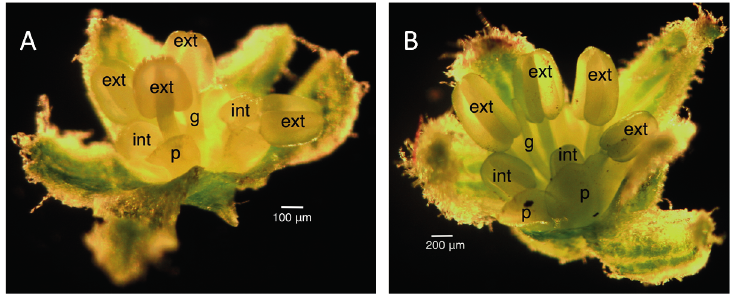
Figure 4. Stages 8 ( A ) and 9 ( B ) male infected floral buds. Stage 9 buds have